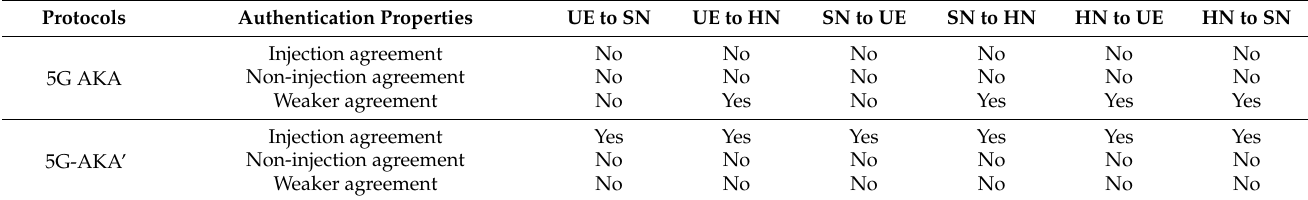
Table 1. The comparative analysis of authentication properties between the two protocols.